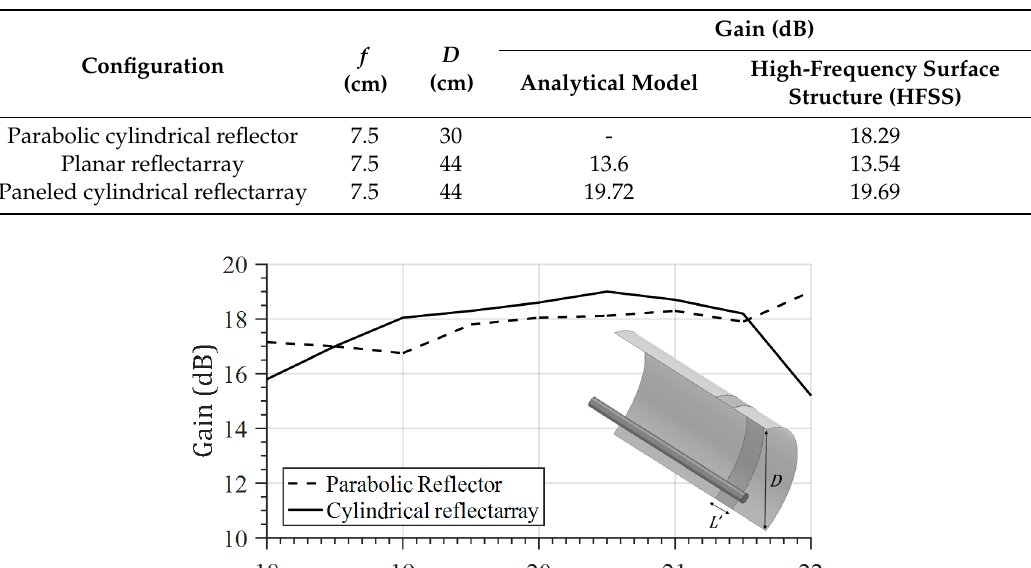
Table 2. Gain and efficiency comparison. Table 2. Gain and e ffi ciency comparison.